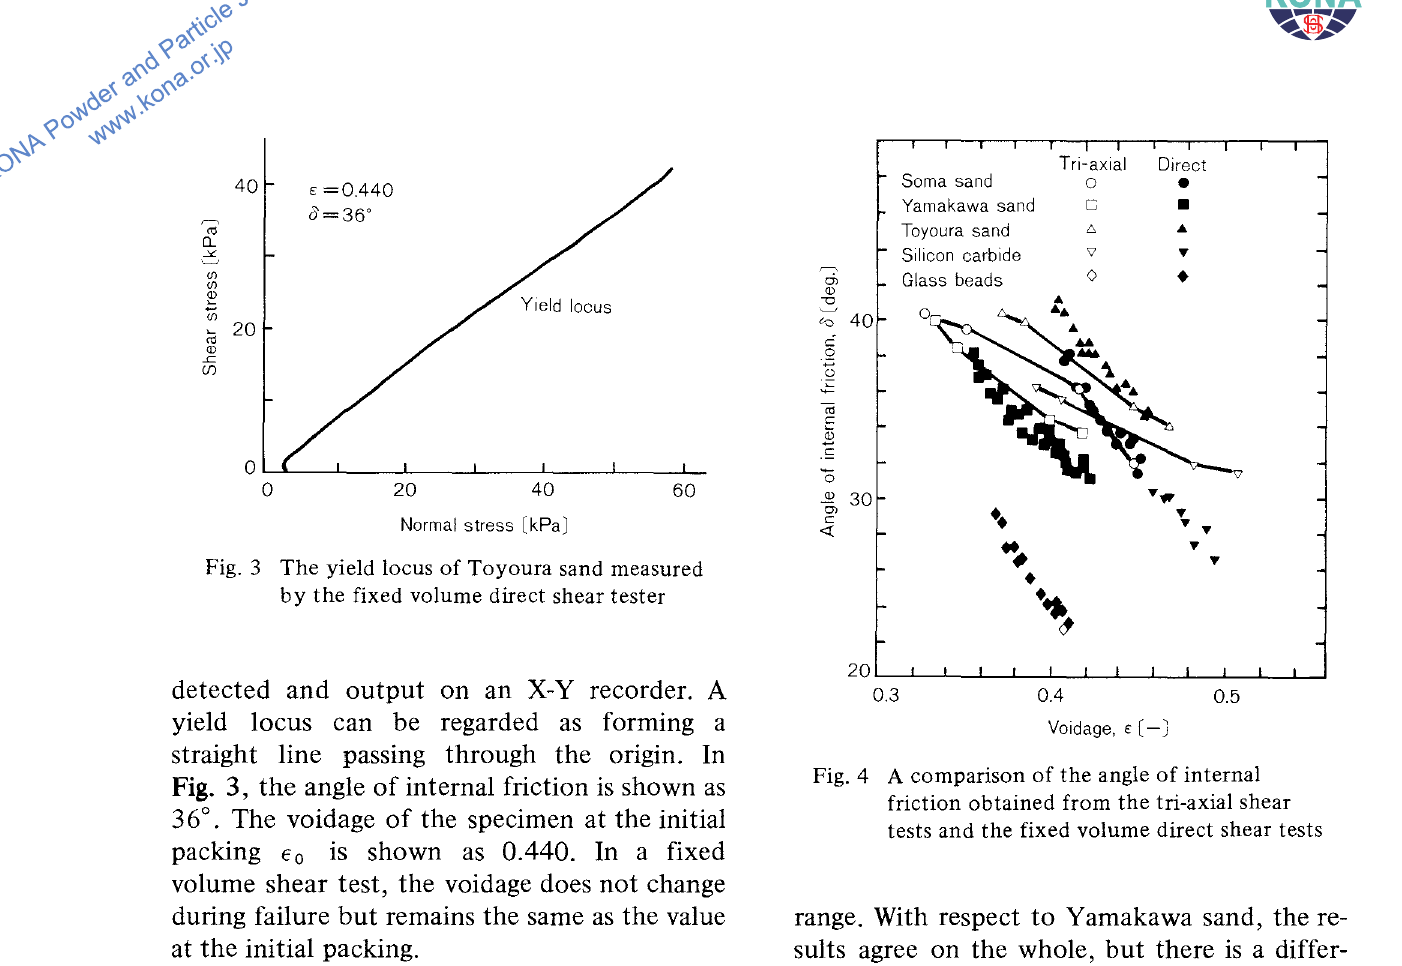
Fig. 4 A comparison of the angle of internal friction obtained from the tri-axial shear tests and the fixed volume direct shear tests